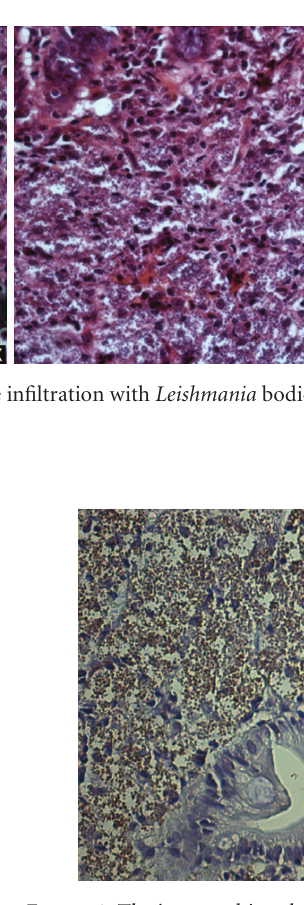
Figure 2: The immunohistochemical study of duodenum fragment tissue confirming Leishmania